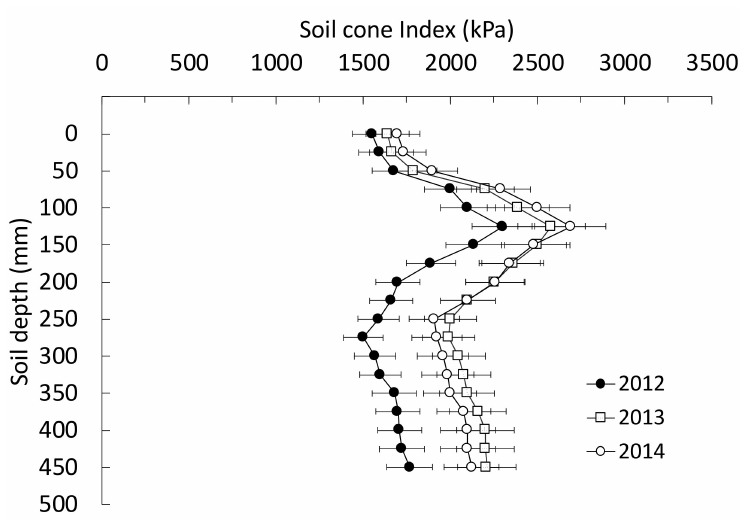
Figure 1. Soil cone index (adjusted for covariate) recorded at the site on seeding days in 2012, 2013, and 2014, respectively. Error bars on mean datapoints ( n = 20) denote standard deviation; p < 0.05 (depth) and p > 0.05 (years).